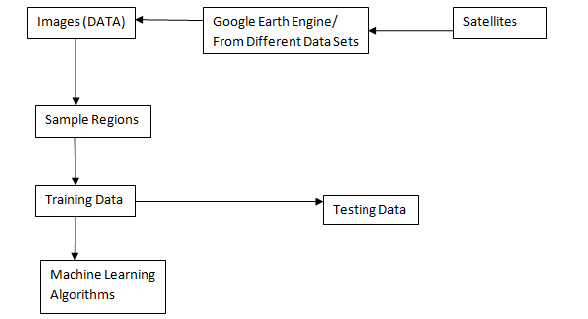
Figure 1: Working Culture Of